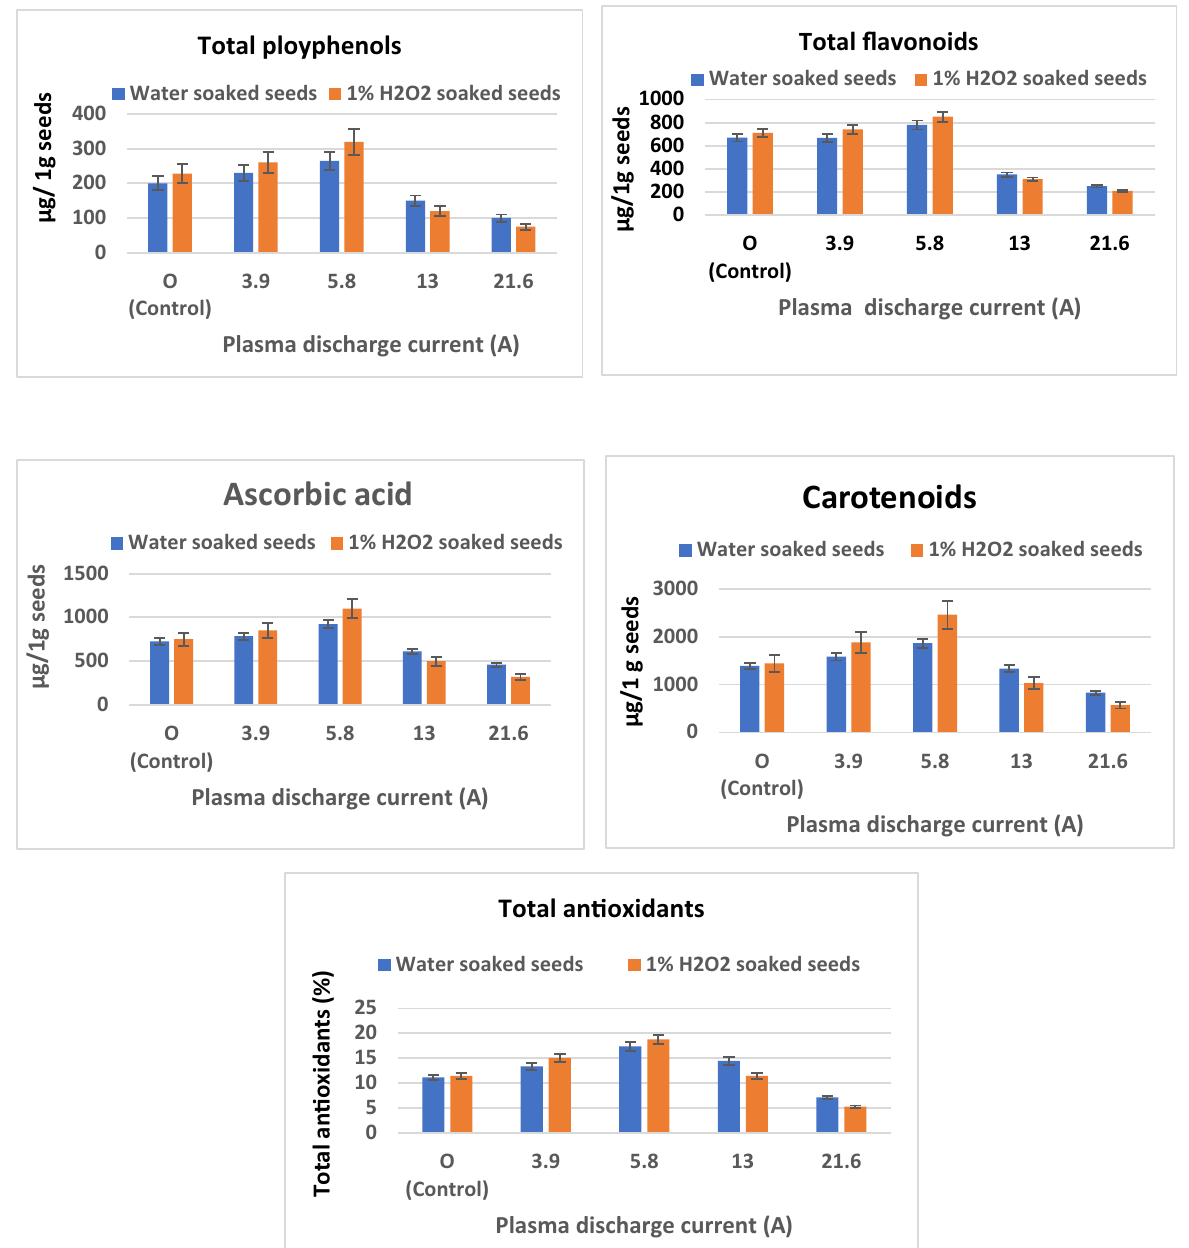
Figure 6. Effect of cold plasma discharge current applied for 10 min to M. oleifera soaked seeds on seedling antioxidants after 30 days of